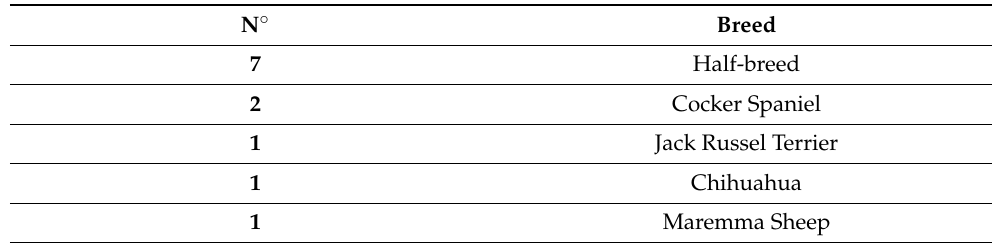
Table 1. List of dog breeds included in the clinical